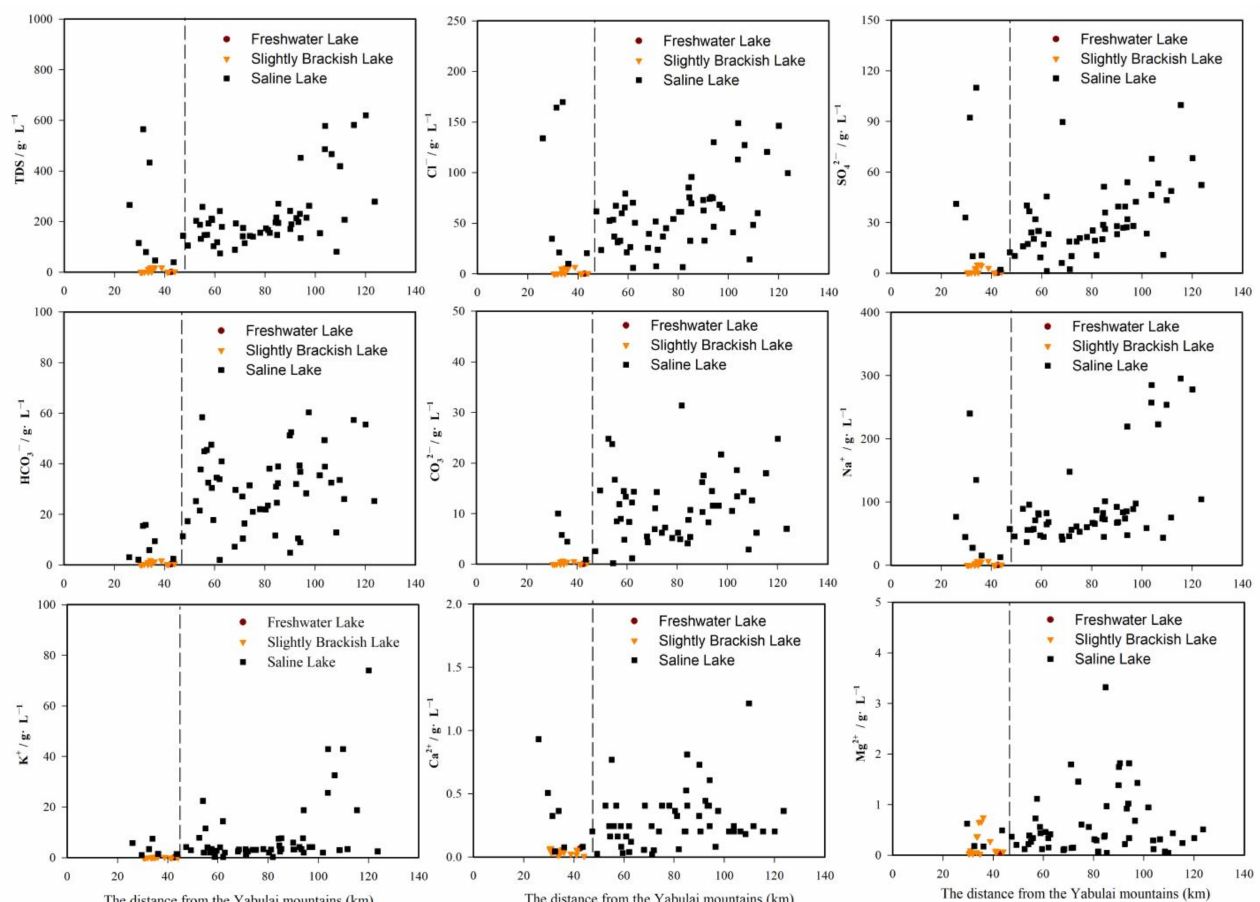
Figure 8. The variability of lake ions distance from the Yabulai